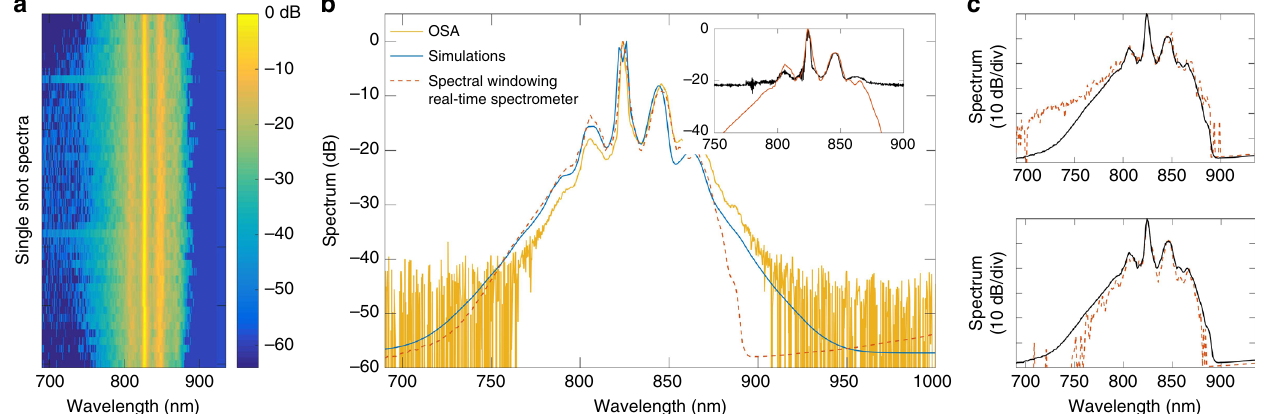
Fig. 6 Experimentally recorded single-shot MI spectra with high dynamic range. a Series of 60 recorded spectra stacked along the vertical direction to illustrate the shot-to-shot fl uctuations seen with MI. b Average spectrum measured with our high dynamic range real-time technique (dashed red), average spectrum measured with an optical spectrum analyser (yellow), and simulated average spectrum (blue). The inset shows the comparison between our 60 dB dynamic range spectral measurement (dashed red) and that using a conventional fi bre-DFT with only ~22 dB dynamic range (black). c Two selected single-shot spectra from experiments (dashed red) compared with the average experimental spectrum (solid